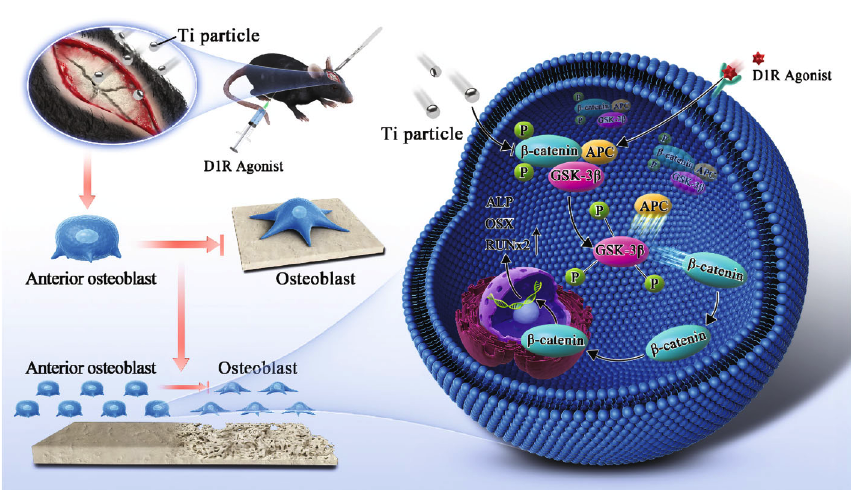
Scheme 1: D1R activation alleviates the osteogenic inhibition caused by wear granules on the mouse skull and alleviates the inhibition of osteoblast di ff erentiation induced by titanium granules. D1R activation can promote the expression of the osteoblast-related proteins ALP, OSX, and Runx2 by activating the Wnt pathway and abrogate the inhibition of osteoblast di ff erentiation induced by titanium